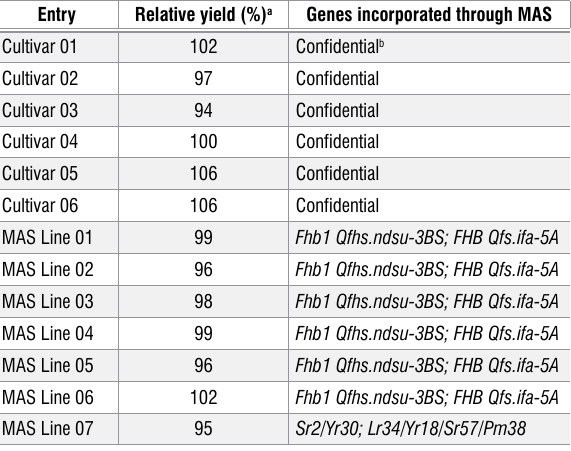
Yield performance of selected marker-assisted selection (MAS) lines of Corteva Agriscience TM compared to commercial